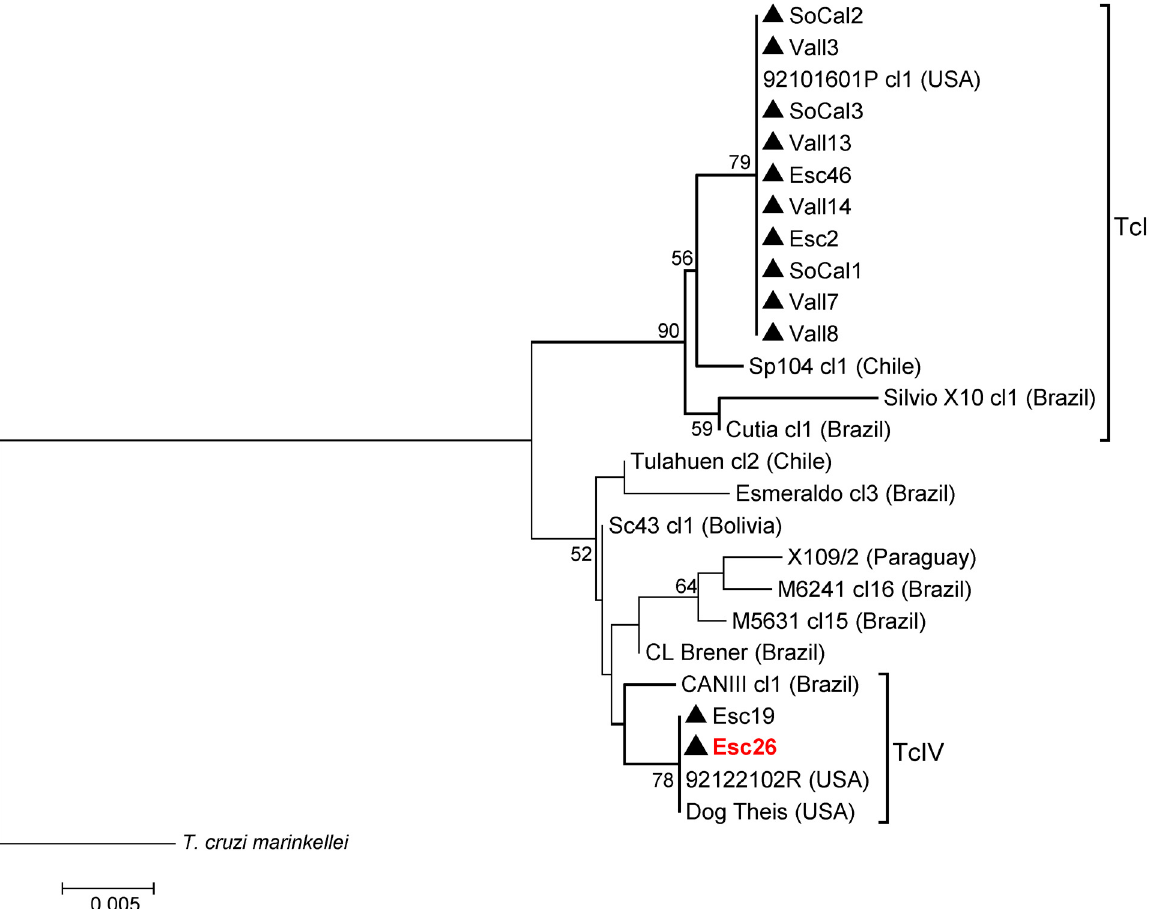
Fig 2. Phylogeny for 26 Trypanosoma cruzi 350 bp RNA-Binding Protein-19 ( RB19 ) sequences. Neighbor-Joining tree constructed in MEGA6 with evolutionary distances computed via Maximum Composite Likelihood. The numbers above the nodes represent bootstrap confidence levels for 2,000 replicates. Only values (cid:1) 50% are shown. The only TcI isolate not obtained in this study is represented by a square. Sequences obtained in this study are indicated by a triangle (Esc = Escondido, SoCal = Southern California, Vall = Vallecito). All other isolates represent published GenBank sequences as listed in S1 Table with their country origin indicated in parentheses. The scale bar indicates the number of nucleotide substitutions per site. Tree is outgroup rooted with T . cruzi marinkellei (TcMark CONTIG 1404).